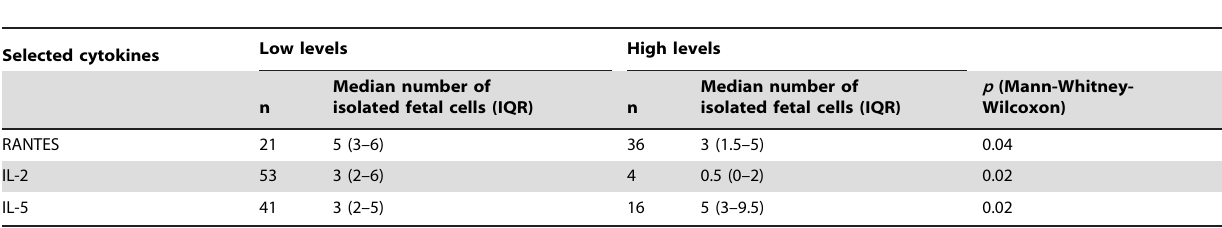
Table 3. The number of isolated fetal cells in 30 ml maternal blood in relation to selected cytokines.